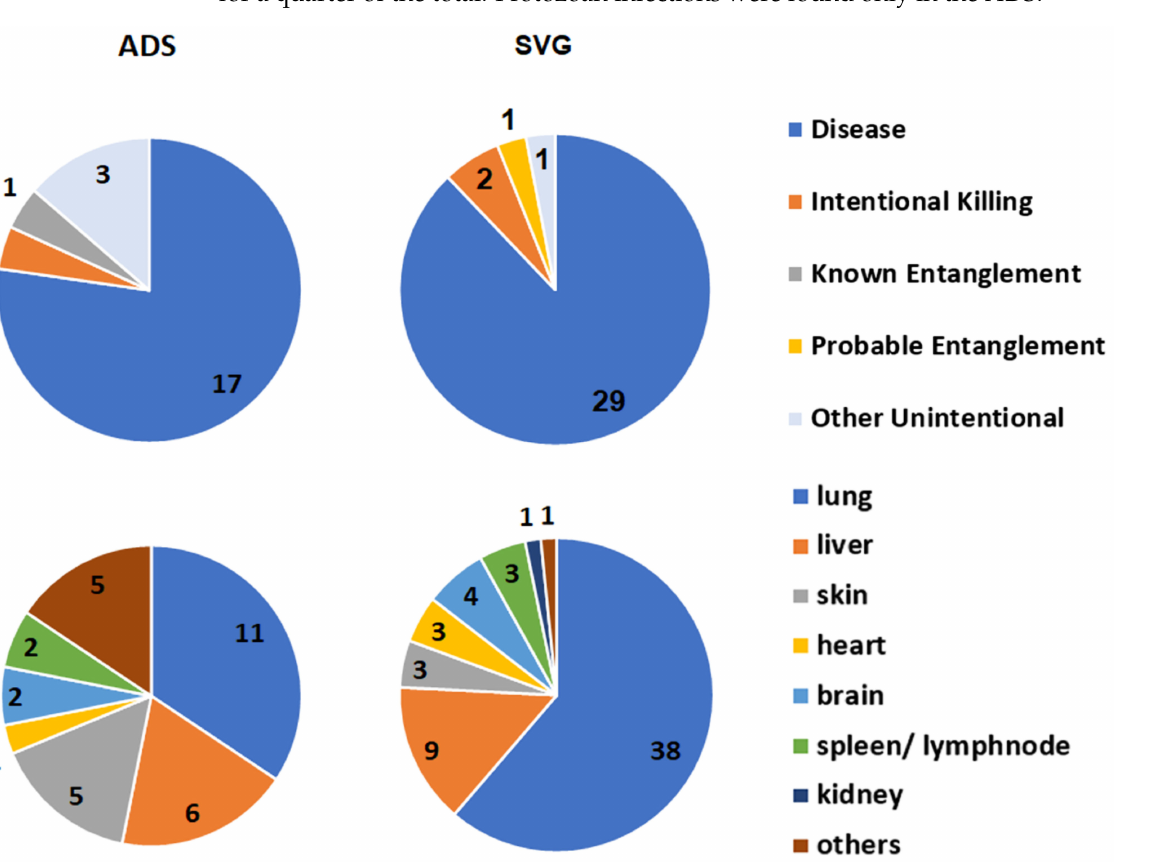
Figure 8. Comparison of the circumstances of death (upper pie charts) and types of infectious inflammation (lower pie charts) for Indo-Pacific bottlenose dolphins ( Tursiops aduncus ) in the Adelaide Dolphin Sanctuary (ADS) and elsewhere in the St Vincent Gulf Bioregion (SVG), South Australia, during 2009–2020. Unknown circumstance of death cases were not included in the proportions. Numbers are the counts of cases in each